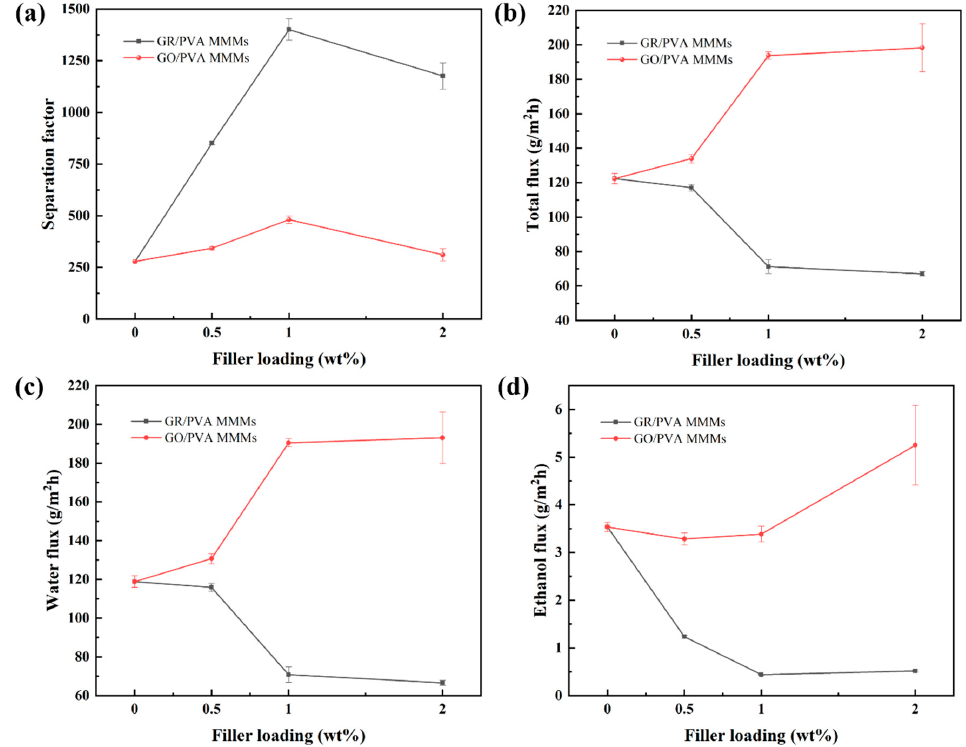
Figure 9. Effect of filler loading on PV performance of GR/PVA and GO/PVA MMMs. ( a ) Separation factor; ( b ) Total flux; ( c ) Water partial flux; ( d ) Ethanol partial flux.